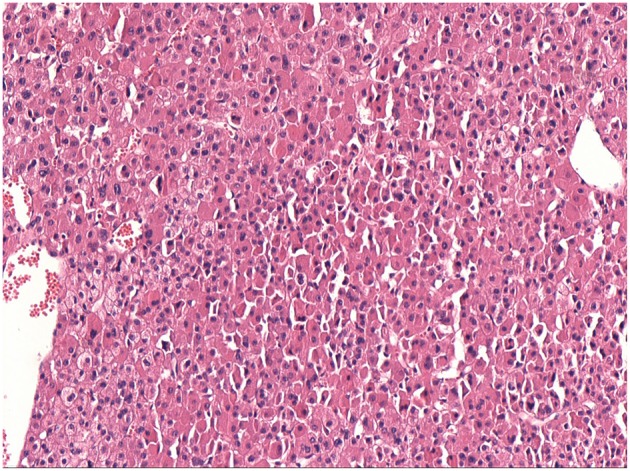
Same as Figure 2.